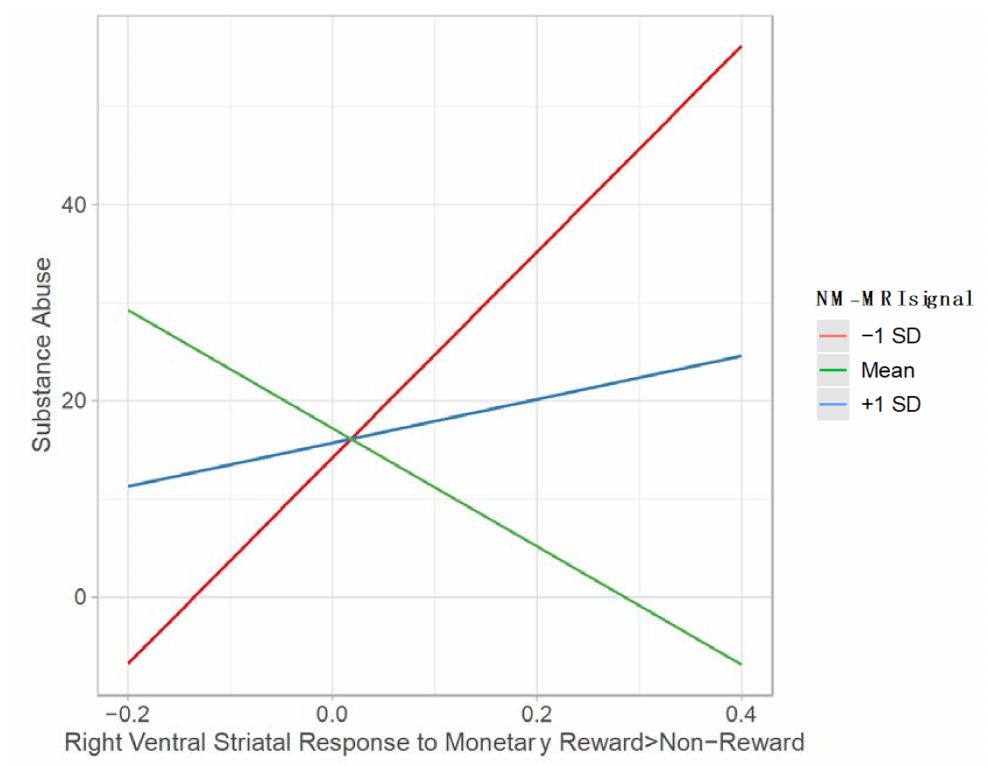
Figure 4. Depiction of moderating effect of NM-MRI signal on the relation between right ventral striatal response to monetary reward (vs. non-reward) and substance abuse. SD = standard